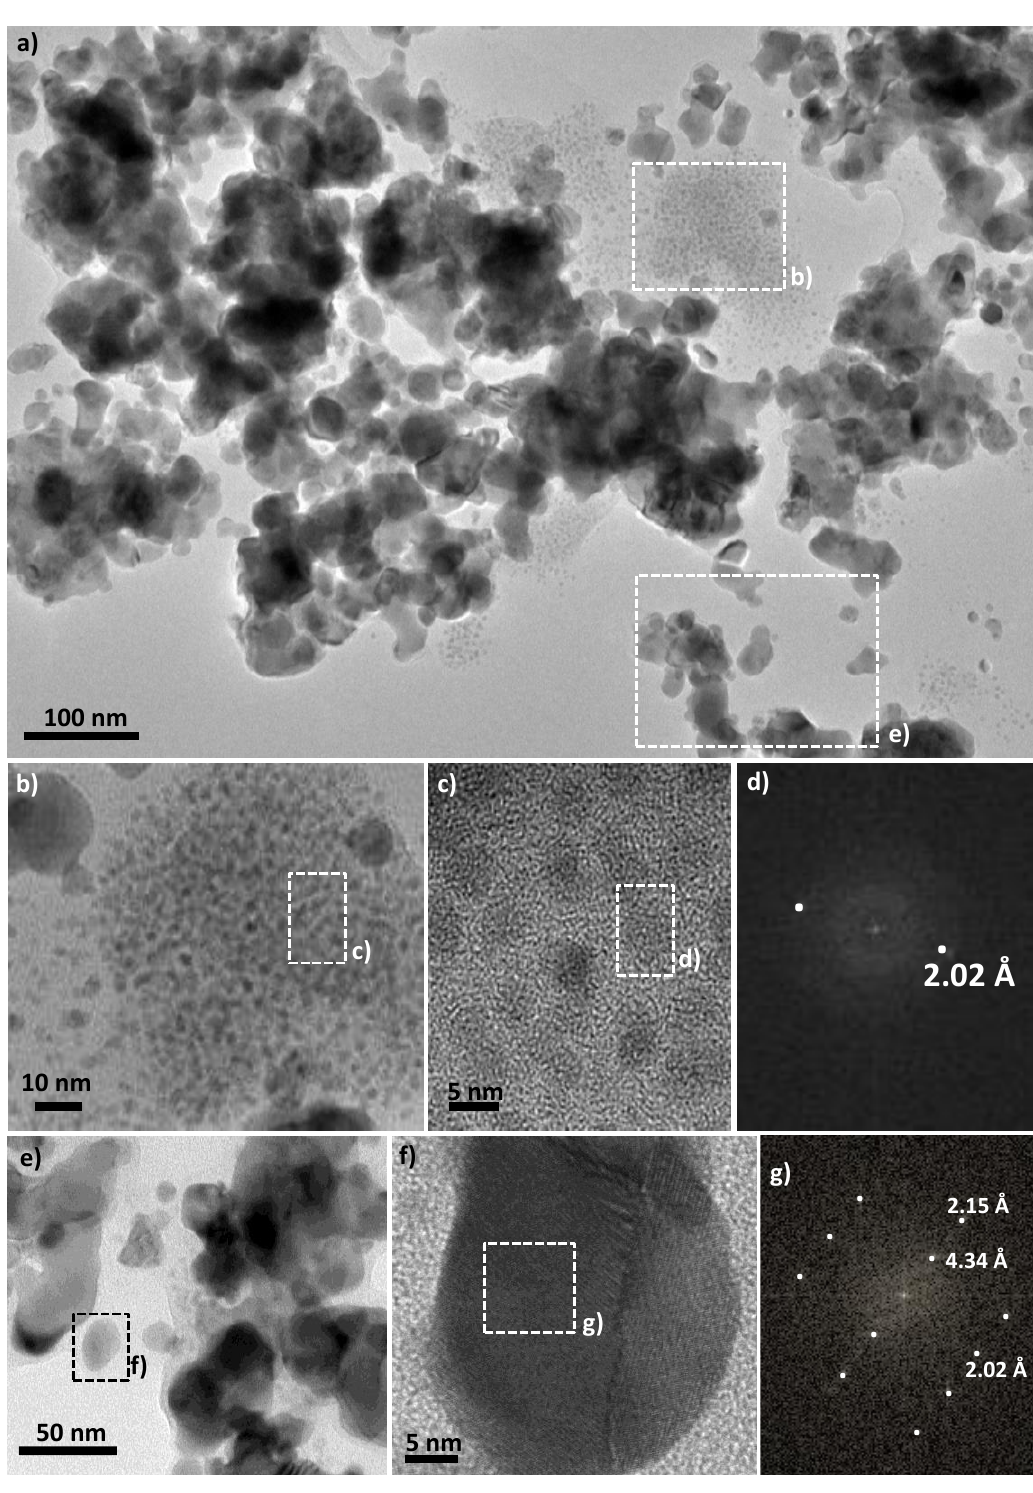
Figure 4. ( a ) TEM micrographs of the plasma treated Ni powder. Two populations of particles can be identified, the smallest and scarcest ones ( b , c ) and the largest ones ( e , f ). Fast Fourier transform (FFT) patterns calculated from high resolution TEM) images (c,f) recorded on representative particles of the two population are given and fully indexed within the fcc Ni structure ( d ) and the hc Ni 2 H one ( g ), respectively. They also point out the effect of the size of the starting metal (in situ or ex situ formed), since a minimal size, larger than 7 nm, is required to stabilize the intermetallic phase instead of the solid solution one.